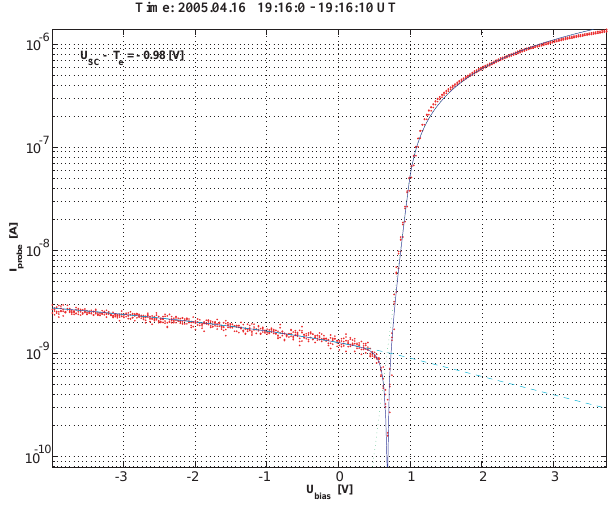
Fig. 2. The current-voltage characteristic (red dots) of a RPWS Langmuir Probe sweep sampled in the outbound part ionosphere of the T5 flyby. Superposed is an OML fit to the data, also indicating the electron and ion current contributions. Derived parameters are v i =4km/s, m i =28, T e =0.08eV, n e =700cm − 3 and U SC = −